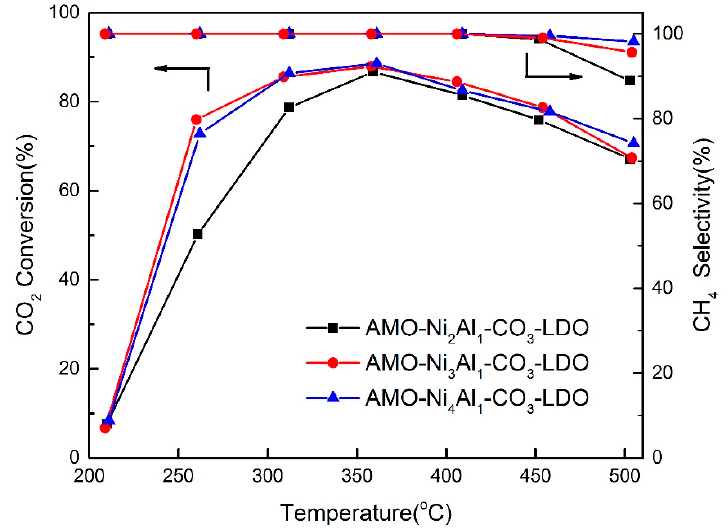
Figure 7. CO 2 conversion (%) and CH 4 selectivity (%) vs T profiles over AMO-Ni 2 Al 1 -CO 3 -LDO, AMO-Ni 3 Al 1 -CO 3 -LDO and AMO-Ni 4 Al 1 -CO 3 -LDO catalysts for the CO 2 methanation.